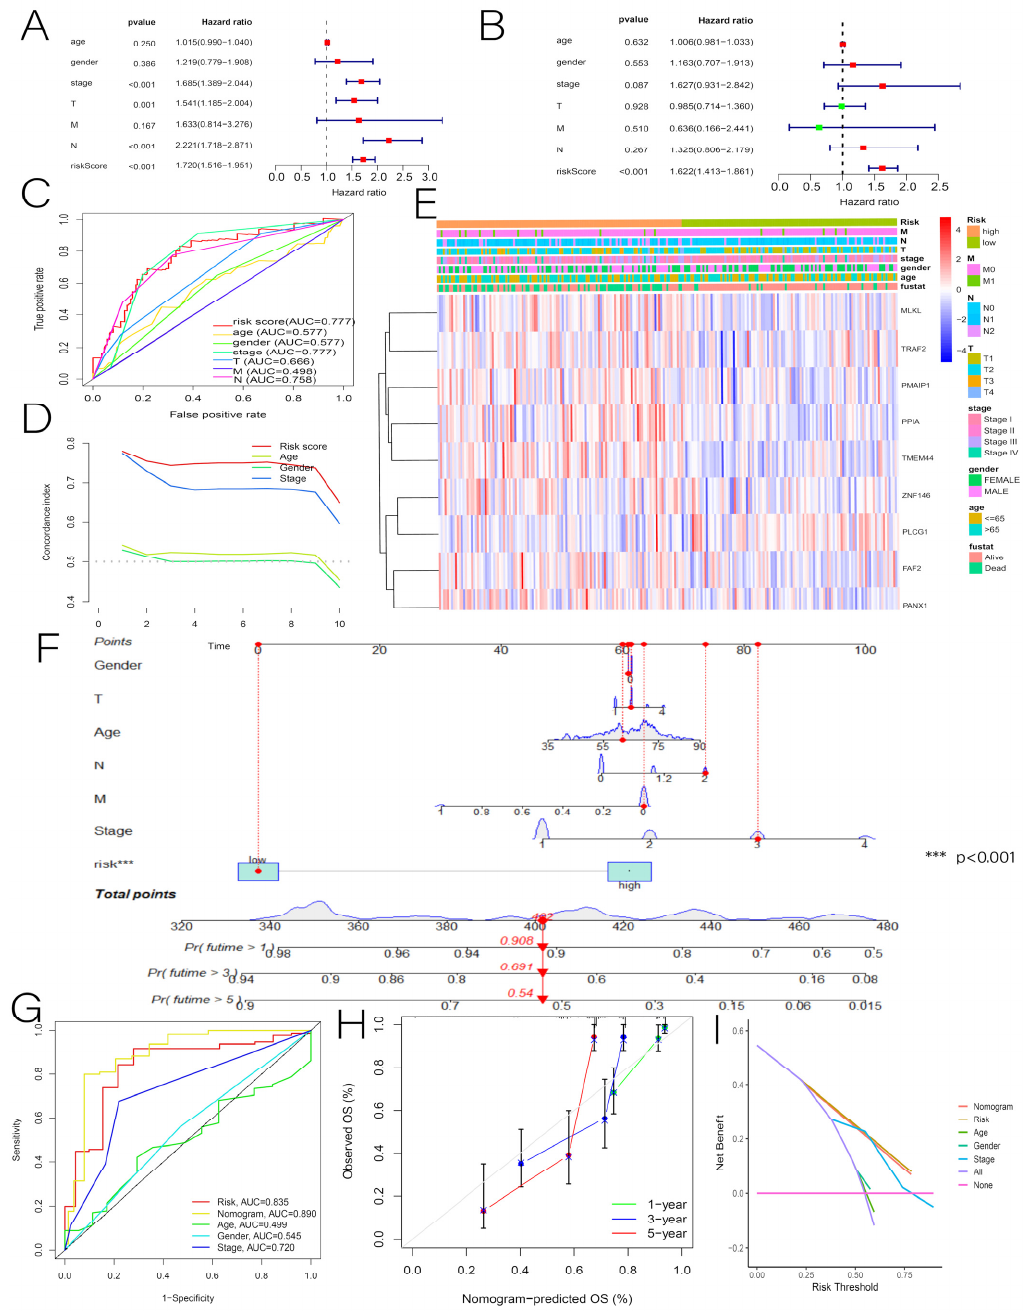
Figure 6. ( A ) Univariate Cox analysis of risk scores and multiple clinicopathological features. ( B ) Multivariate Cox analysis of risk scores and numerous clinicopathological features. ( C , D ) ROC and C-index were used to determine the independent predictive value of risk scores and clinicopathologic features. ( E ) Heat map of clinicopathological characteristics. ( F ) Construction of the nomogram for 1-year, 3-year, and 5-year OS. ( G – I ) Calibration curves, ROC, and DCA were used to determine the accuracy of the nomogram. *** p <